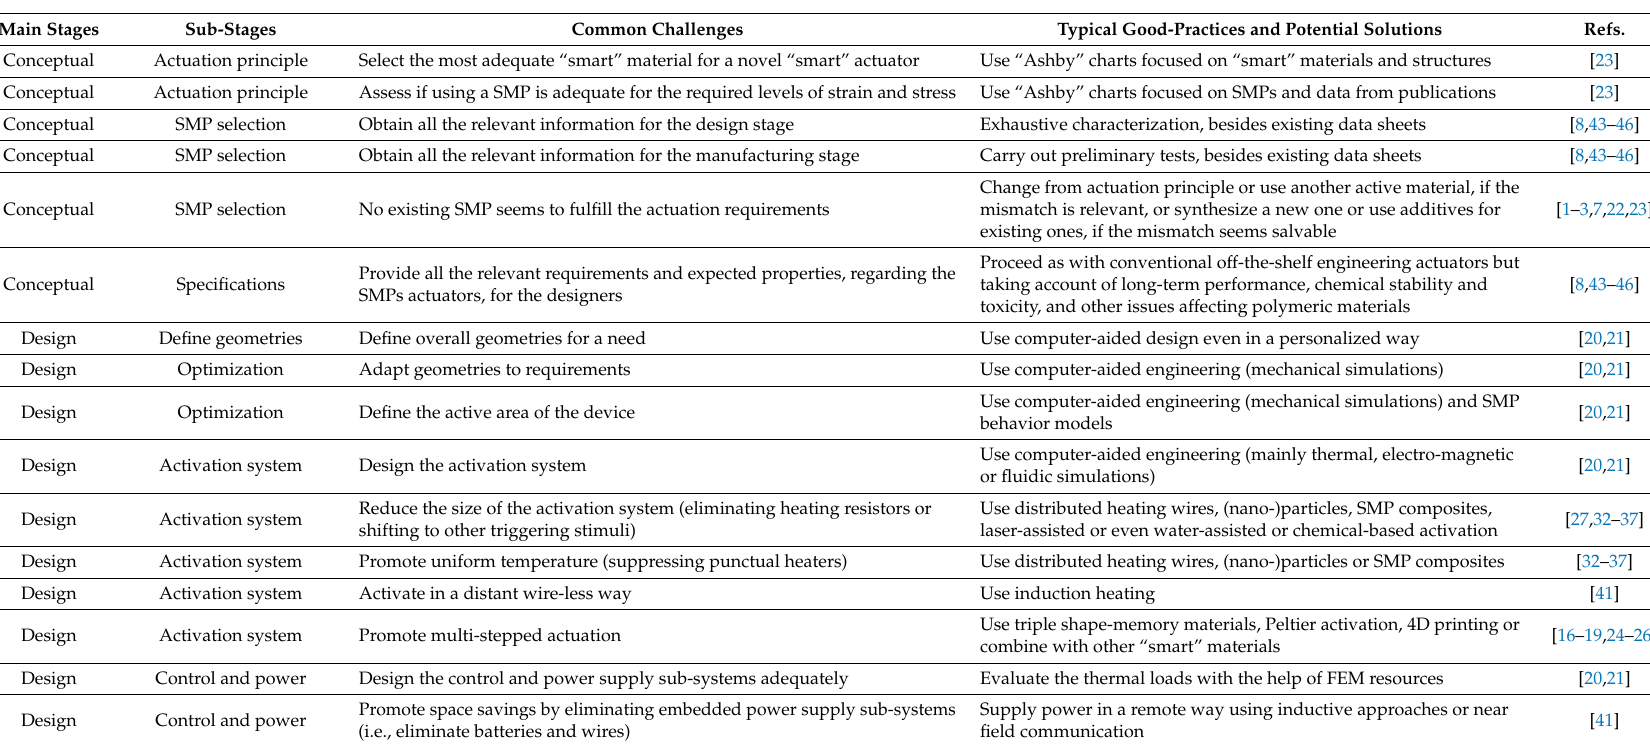
Table 1. Main challenges and solutions in the conceptual and design stages for the development of “smart” systems based on shape-memory